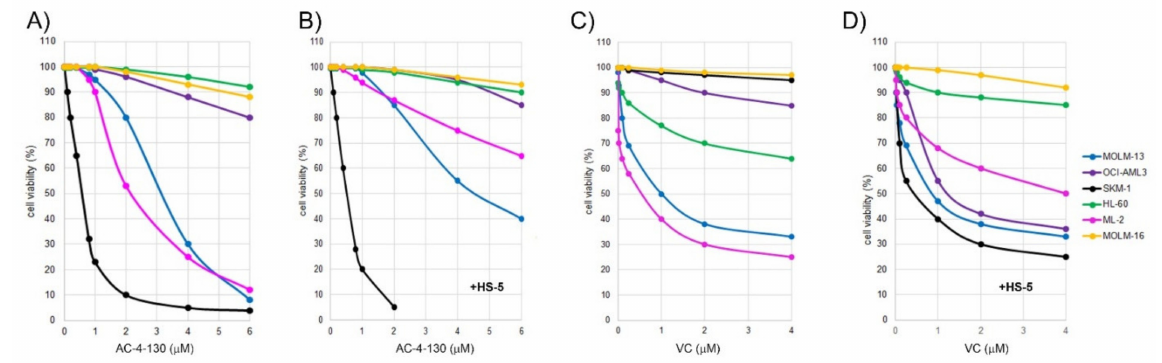
Figure 1. Dose-response curves of AML cell lines. AML cells were treated with the STAT5 inhibitor AC-4-130 ( A , B ) or the BCL2 inhibitor venetoclax ( C , D ) for 20 hours in the absence ( A , C ) or in the presence ( B , D ) of HS-5 stroma cells. Cell-viability data are average values of multiple repeat measurements per dosage. The standard deviation was